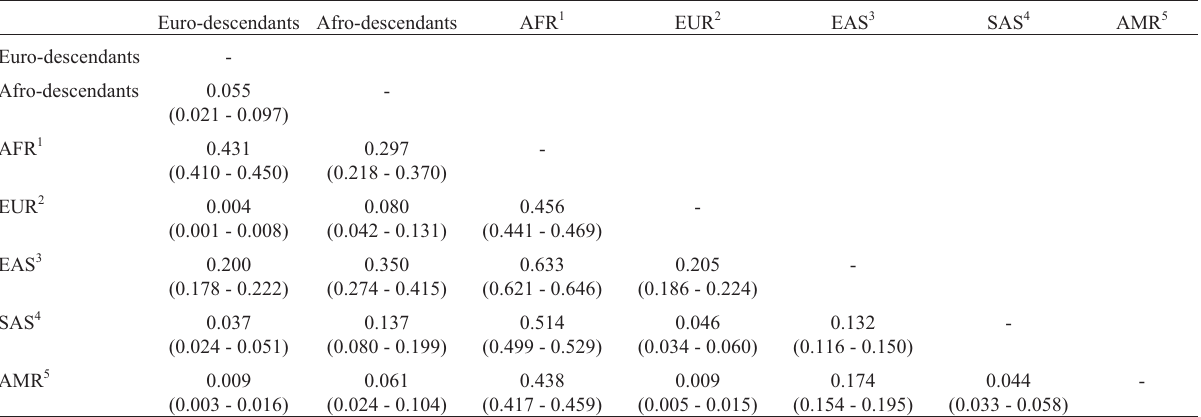
Table 3 - Pairwise F ST among South Brazilian population and populations evaluated in 1000 Genome